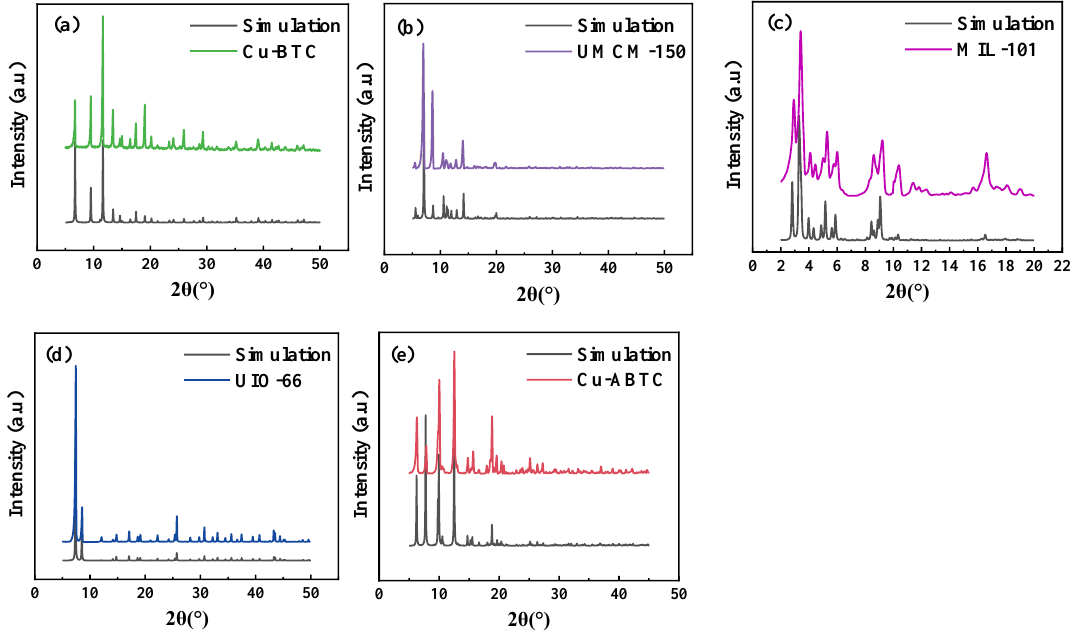
Figure 1. XRD spectra of the five MOFs ( a ) Cu-BTC; ( b ) UMCM-150; ( c ) MIL-101(Cr); ( d ) UIO-66; and ( e ) Cu-ABT C.